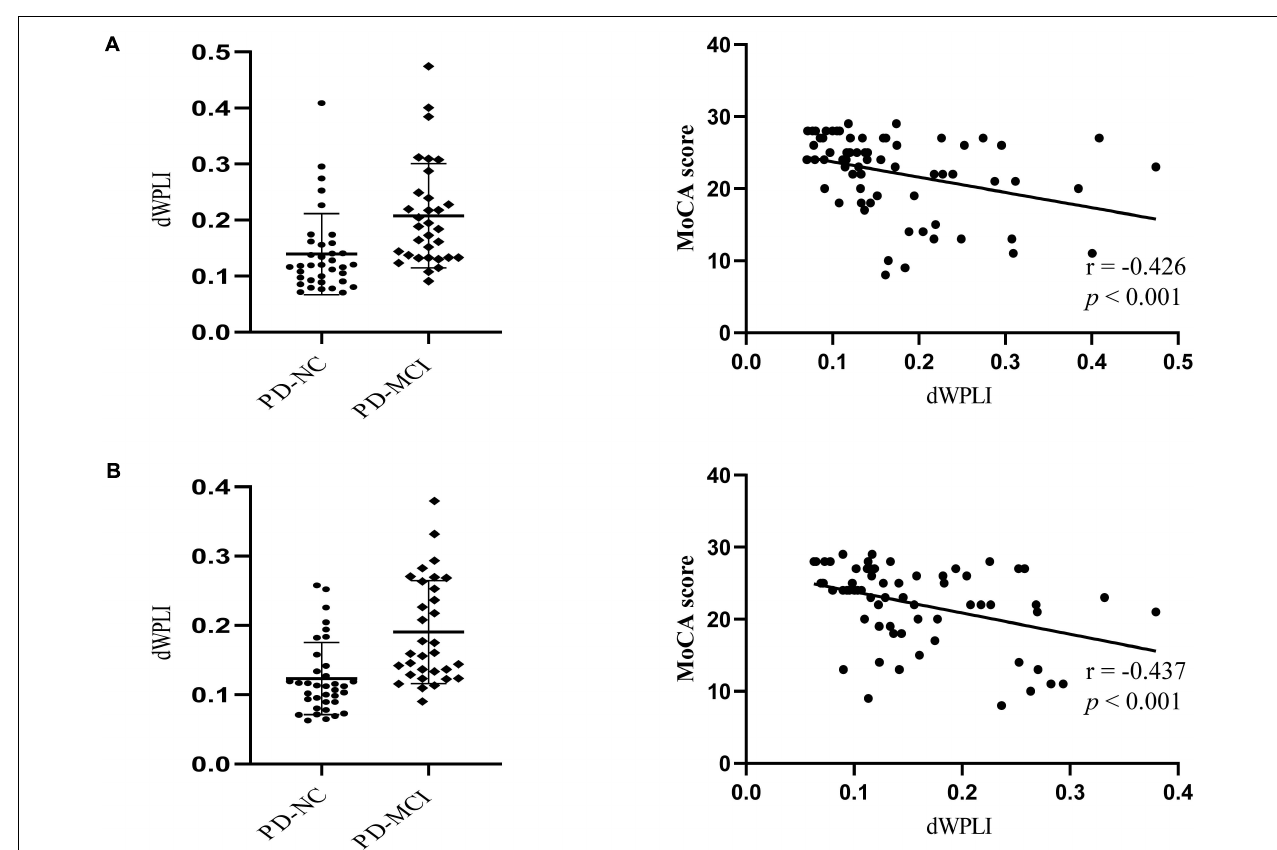
FIGURE 2 | The MoCA scores are negatively correlated with the left PMFG-based functional connectivity change (A) and the right PMFG-based functional connectivity change (B) after adjusting for sex, age, and education level. Scatterplot depicting seed-based functional connectivity significantly differed between the groups. dWPLI, debiased weighted phase lag index; MoCA, Montreal Cognitive Assessment; PD-MCI, Parkinson’s disease with mild cognitive impairment; PD-NC, Parkinson’s disease with normal cognition. TABLE 2 | Logistic regression analysis for cognitive status in PD patients based on the significant functional connectivity with the left PMFG and right PMFG, respectively. B S.E. Wald p value OR 95% CI Left PMFG, per 0.1 U 1.082 0.421 6.616 0.01 1.294–6.725 Right PMFGI, per 0.1 U 2.423 0.753 2.578–49.335 CI, confidence interval; OR, odds ratio; PMFG, posterior division of the middle frontal gyrus.